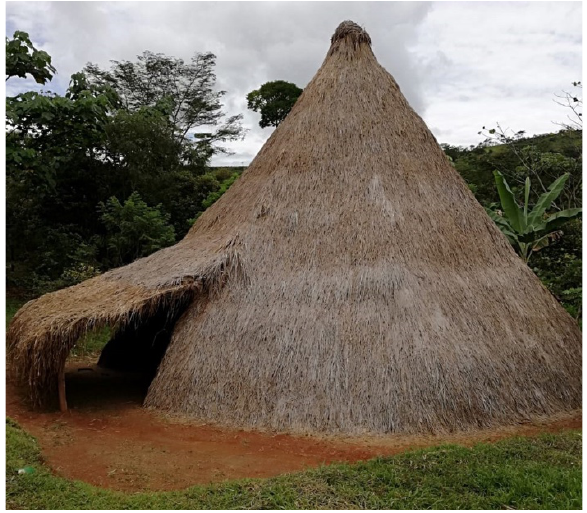
Figure 6. Bribri Cosmic House in Cabagra (Costa Rica).